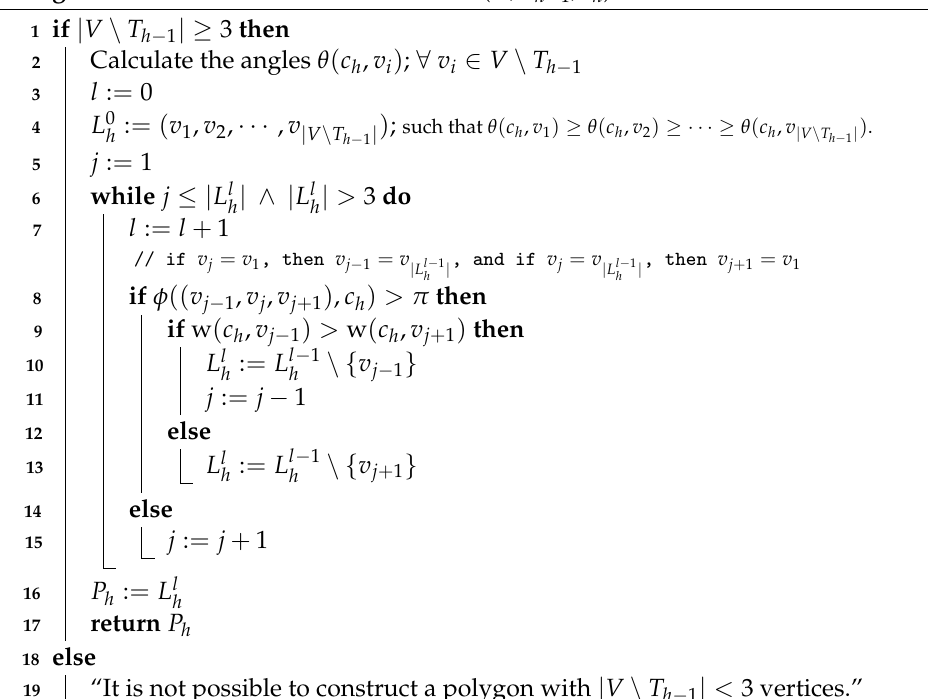
Algorithm 5: INNER − CONVEX − HULL ( V , T h − 1 , c h